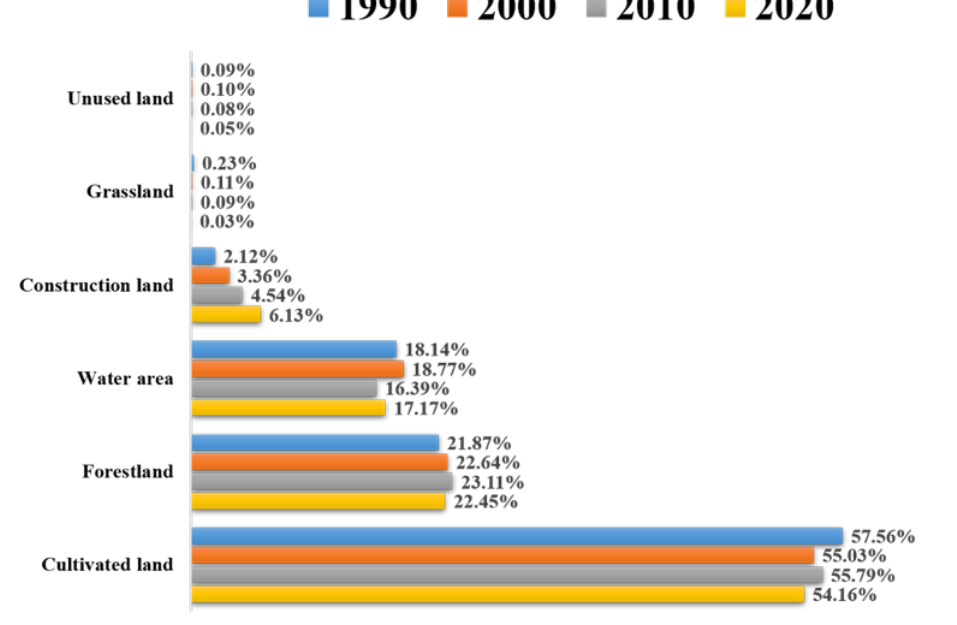
Figure 4. Clustered bar chart of land use types from 1990 to 2020. Table 2. Areas of land use types from 1990 to